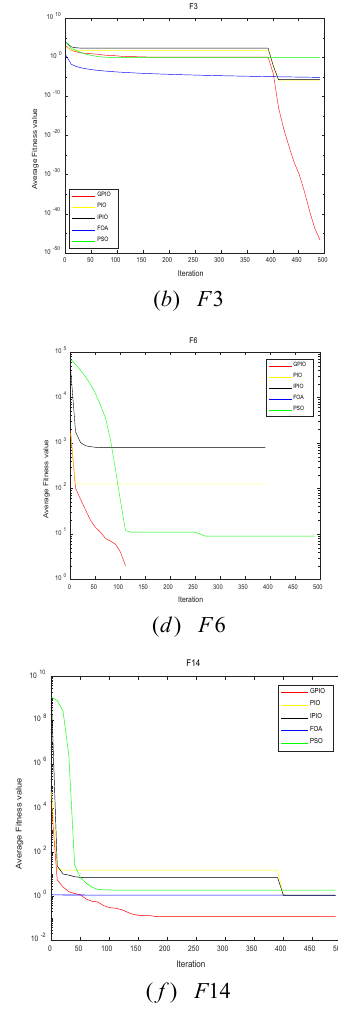
Fig. 1. Suitability value change curve of partial